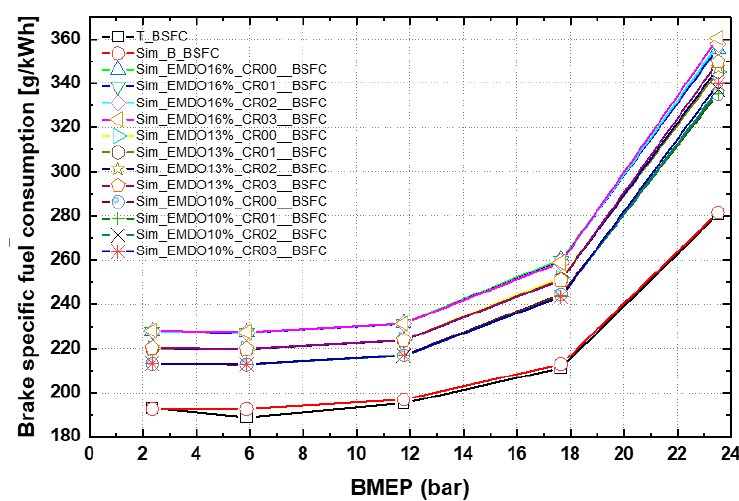
Figure 13. Characteristics of the brake specific fuel consumption versus the turbocharger compression ratio and emulsified marine diesel oil.